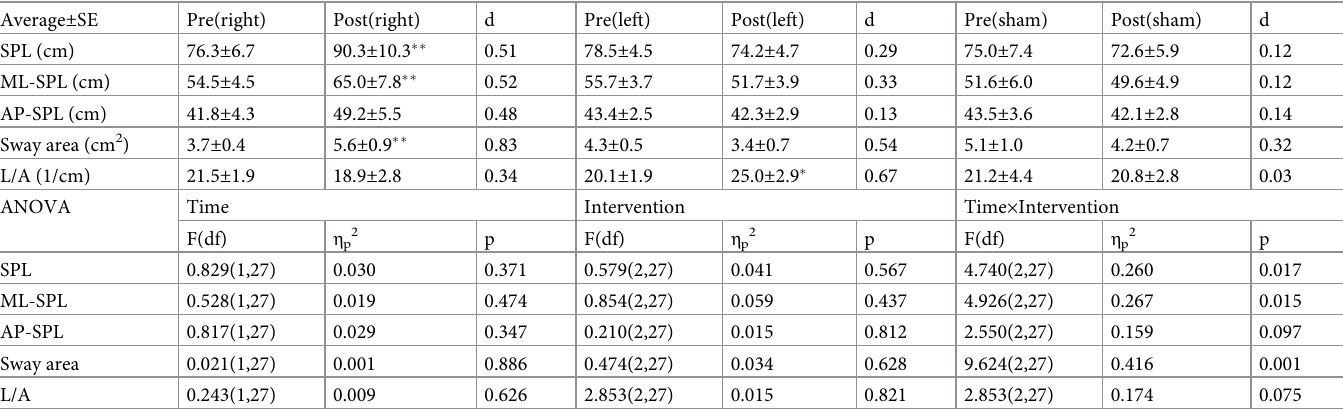
Table 1. Effect of C-tDCS in SPL, ML-SPL, AP-SPL, sway area, and L/A with EO